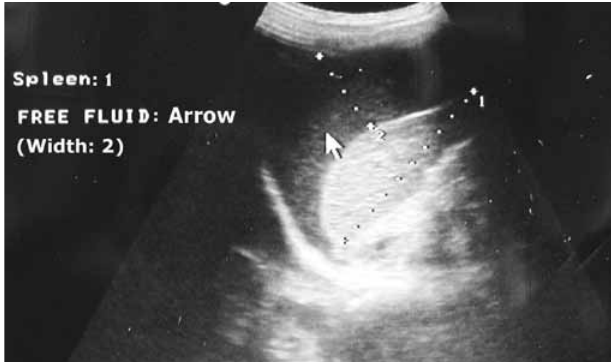
Fig. 3. Sonar image showing haematoma (arrow) around